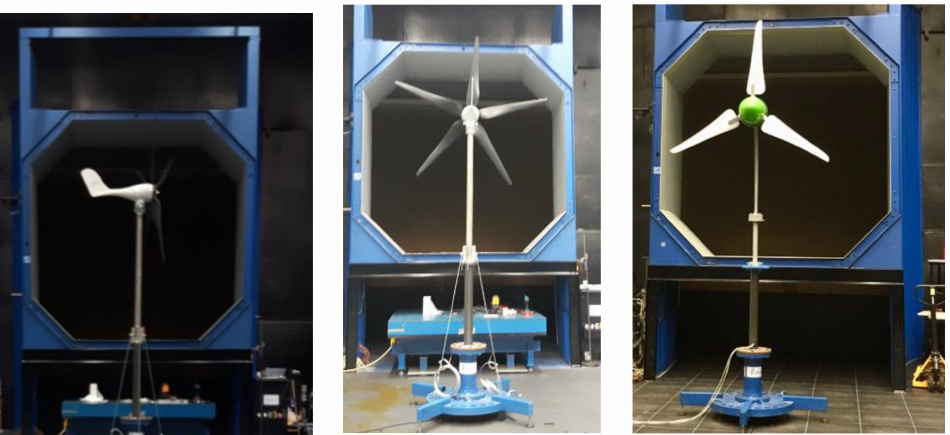
Figure 5. Photo-compilation of the micro wind turbines installed in front of the nozzle of the Open Jet Tunnel, ( left photo) 5 bladed upwind in skewed flow configuration, ( middle photo) 5 bladed upwind turbine in 0 ◦ skew angle and ( right photo) 3 bladed downwind